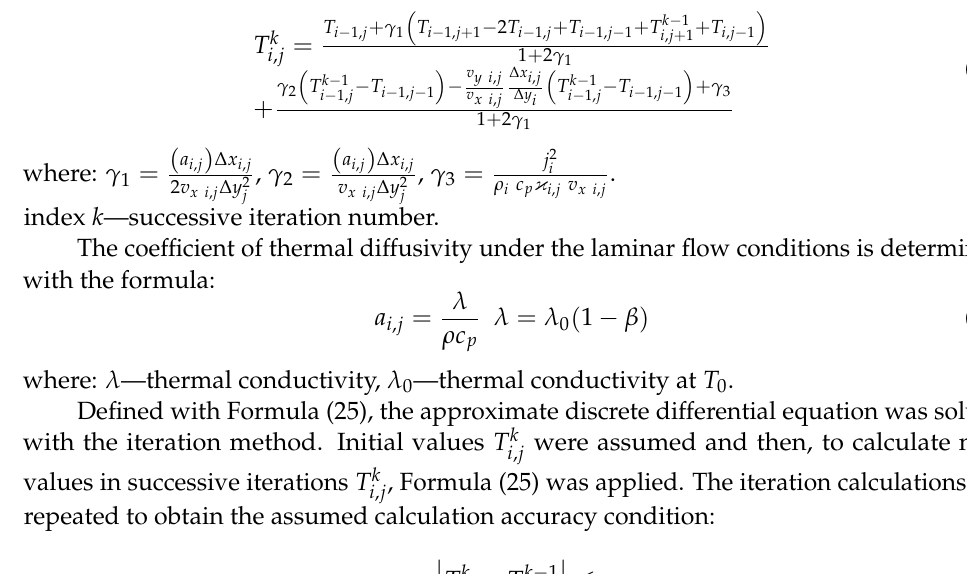
Figure 3. Numerical grid of the electrolyte and hydrogen mixture flow area.